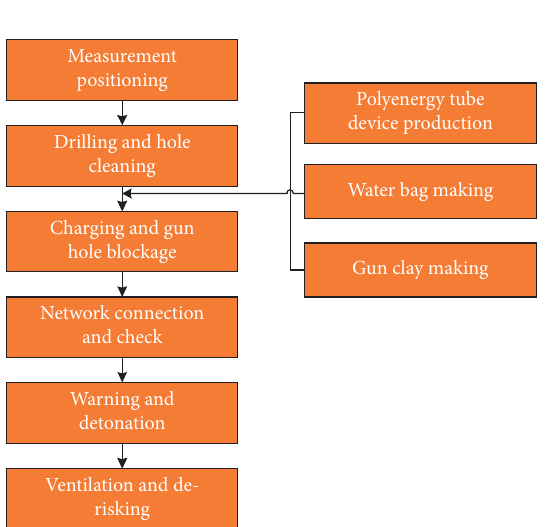
Figure 28: Polyenergy hydrodynamic smooth blasting construc- tion process.